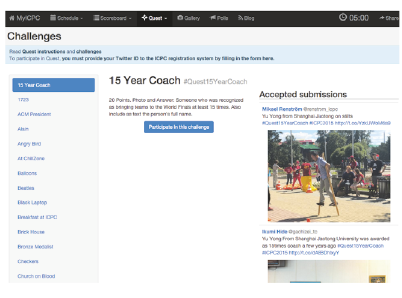
Figure 4: Quest challenges.